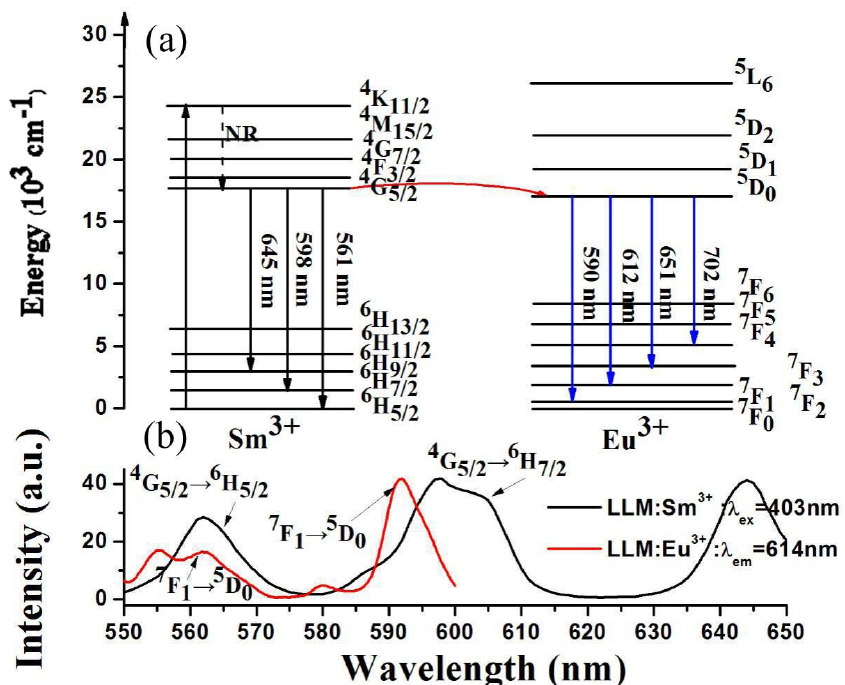
Figure 7. ( a ) The schematic level diagram showing the energy transfer process from Sm 3+ → Eu 3+ ; ( b ) The spectrum overlap between the emission of Sm 3+ and the excitation of Eu 3+ .